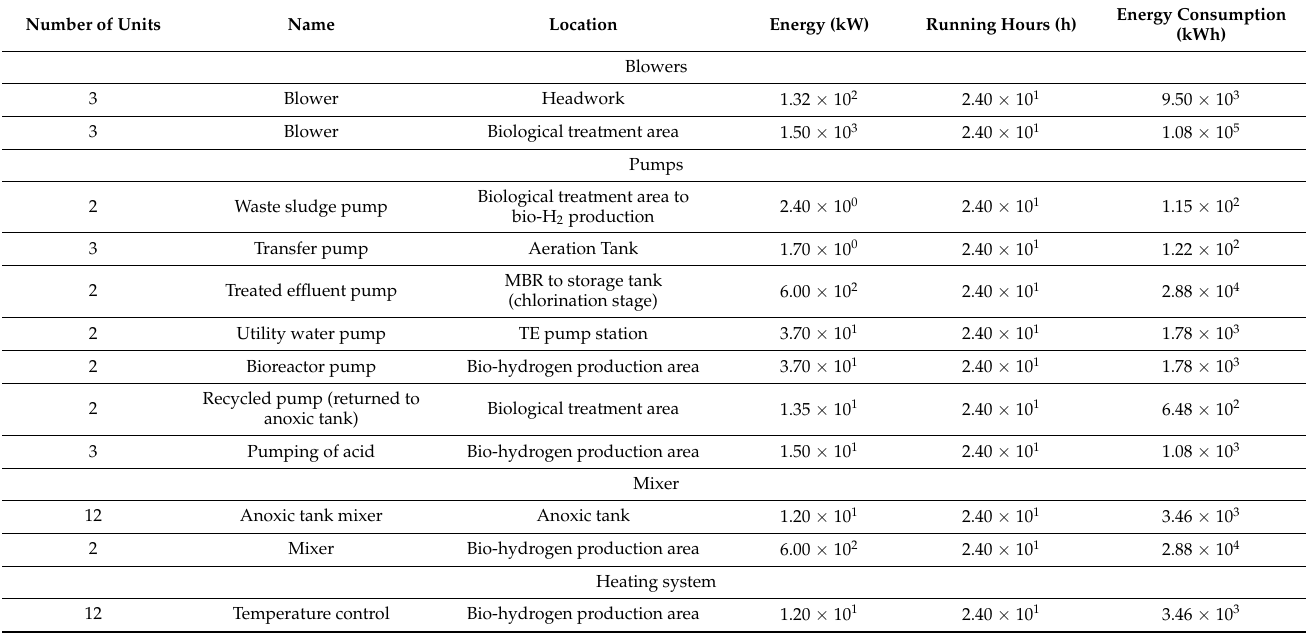
Table 4. The energy flow of the system boundary.